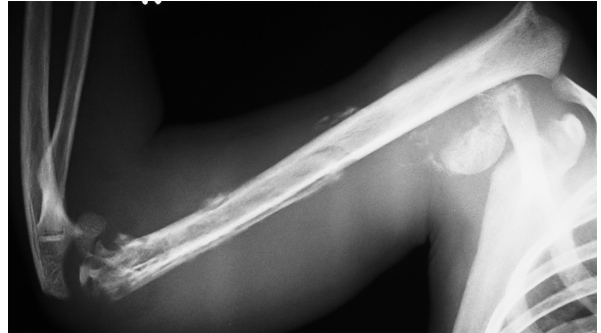
Figure 1. A case of haematogenous osteomyelitis-septic arthritis of the right humerus in an 11-year-old child showing fracture– dislocation of the shoulder, sequestration of the distal half of the di- aphysis, and septic arthritis of the elbow joint. The infection was not preceded by any closed or open fracture. A history of blunt trauma prior to the onset was not recorded in this specific